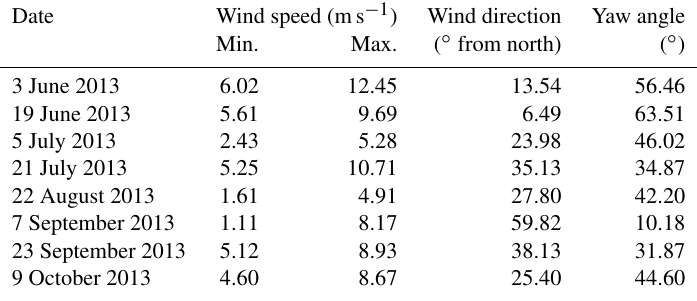
Figure 2. Flux Source Area Model (FSAM) footprint, as percentage of the fetch area, of the eddy covariance (EC) system overlaid on a LAI map of the alfalfa crop (date of Landsat-8 overpass – 21 July 2013). Table 1. Details of wind parameters at the time of satellite